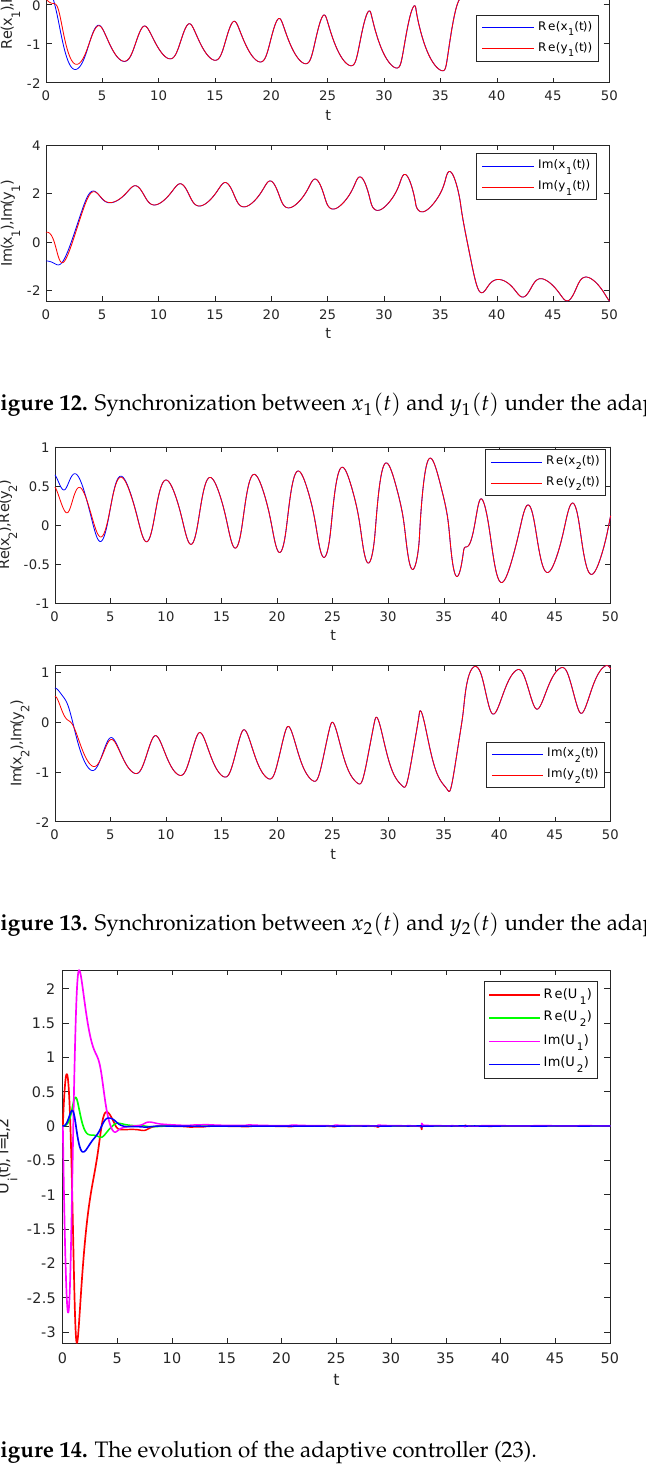
Figure 14. The evolution of the adaptive controller